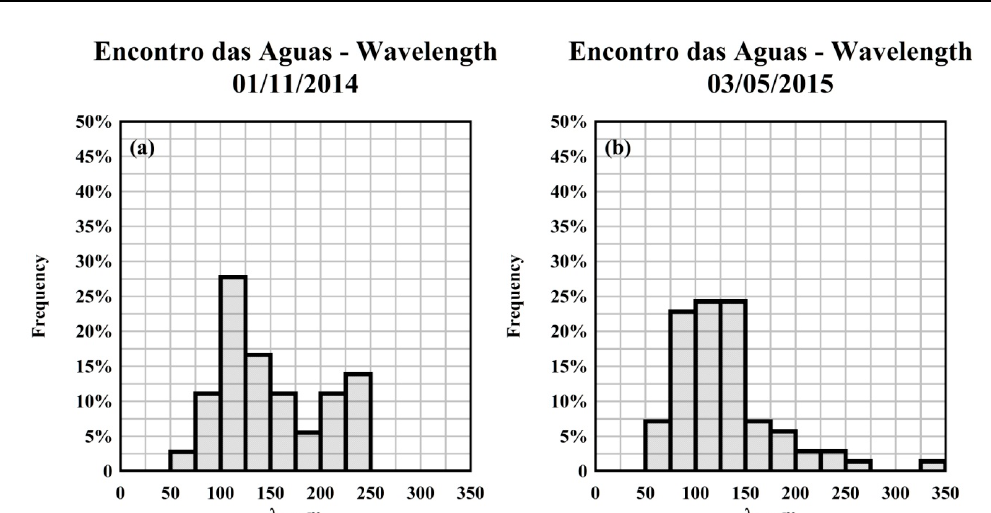
Figure 9. Frequency distribution of bedform wavelength λ bf for ( a ) FS − CNS1 and ( b ) FS −